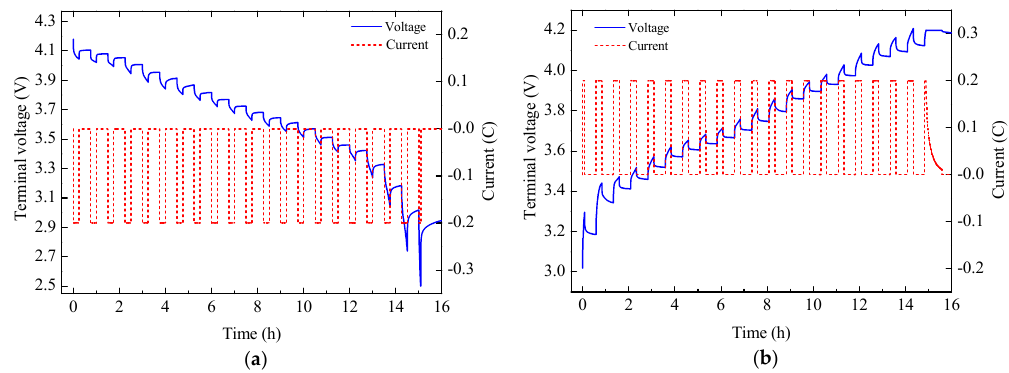
Figure 2. The curves of current and voltage: (a) in the CCID test; (b) in the CCIC test.